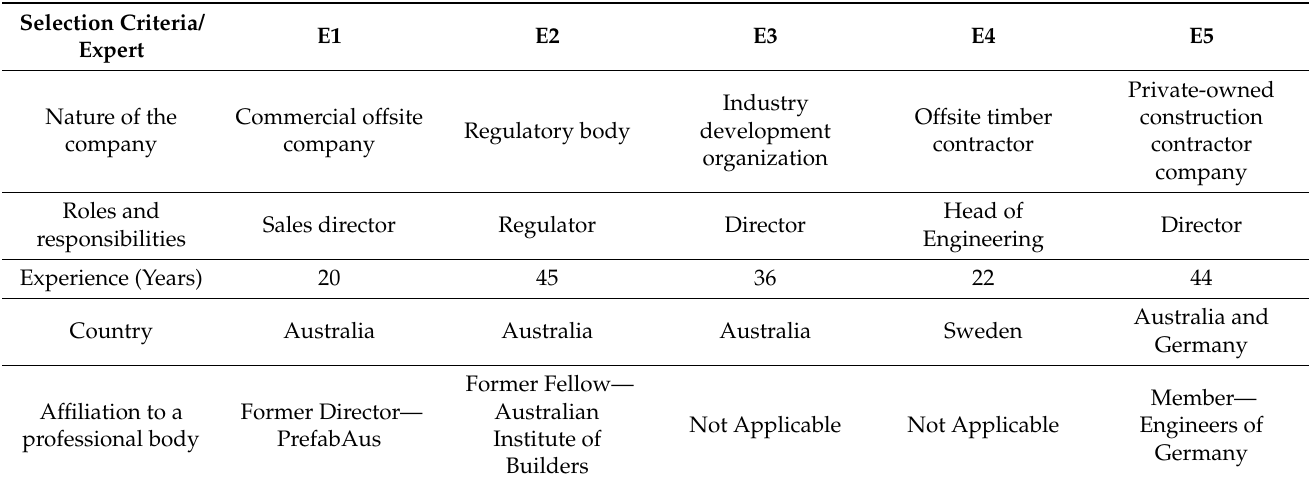
Table 1. Summary of expert